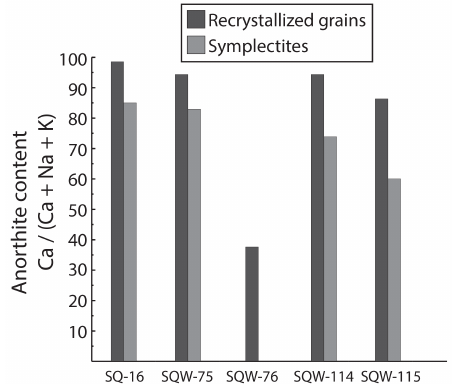
Figure 5. Histogram showing the anorthite content of recrystallized plagioclase grains and plagioclase grains in symplectites.